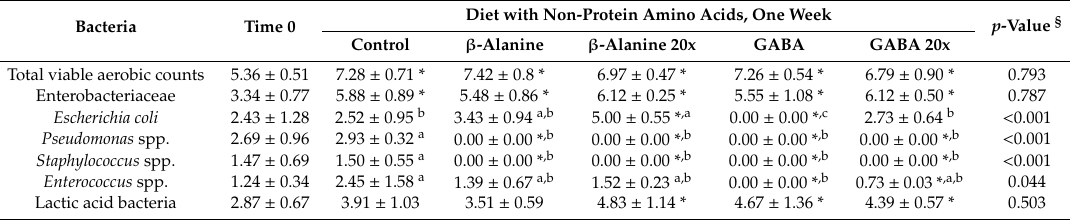
Table 3. Bacterial counts (log CFU per samples log CFU per samples ± s.d.) obtained from the honey bees’ ventriculum after one week of non-protein amino acid (GABA and β -alanine)-enriched diet administration.